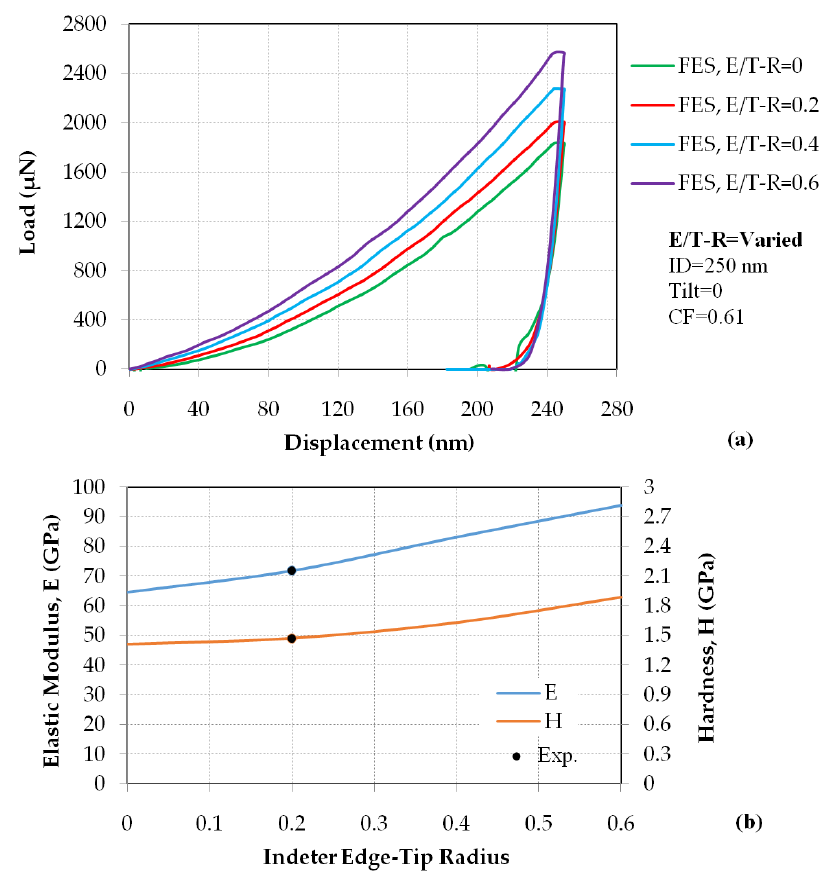
Figure 10. ( a ) Structural responses, and ( b ) variation in elastic modulus and hardness during nanoindentation experiments of aluminum 1100 with different indenter edge-tip radii.